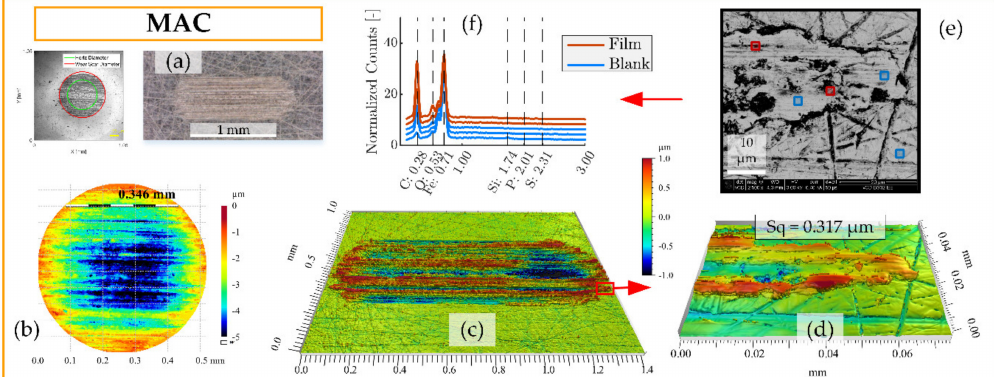
Figure 6. Surface analysis of SRV-3 steel samples lubricated with neat MAC under conditions {150 N/2.4 GPa/AIR}. ( a ) Overview of ball and disc wear scars. ( b ) Detailed view of ball wear scar topography as seen by 3DP with 10 × objective (curvature removed). ( c ) Disc wear scar topography seen by 3DP using 10 × objective and ( d ) detail at 50 × objective. ( e ) scanning electron microscopy with energy-dispersive X-ray spectroscopy (SEM-EDS) analysis of region corresponding to topography in ( d ). ( f ) EDS spectra of regions of interest.